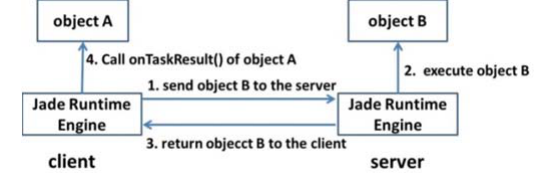
Figure 5: Jade programming model provides a mechanism for object B to no- tify object A when object B finishes execution. Object A must implement the OnTaskReturnedListener in order to receive the